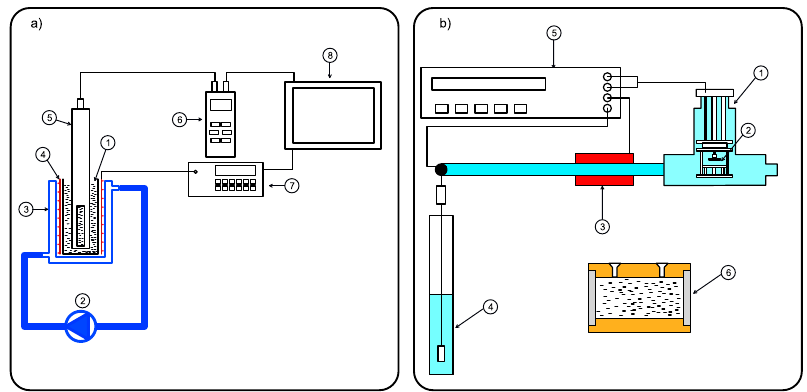
Figure 1. Scheme of ( a ) direct current conductivity measurement station: 1–nanofluid sample, 2–heater/refrigerator circulator, 3–water jacket, 4–heater, 5–conductivity probe, 6–conductivity meter, 7–heater controller, 8–computer with LabView software, ( b ) dielectric properties: 1–temperature stabilization chamber, 2–measuring cell holder, 3–heater, 4–column with compressed air, 5–impedance analyzer and temperature controller, 6–measuring